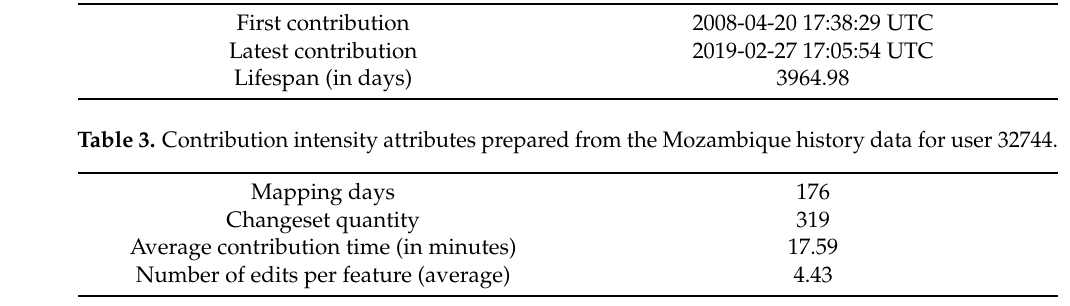
Table 2. Contribution lifespan attributes prepared from the Mozambique history data for user 32744.